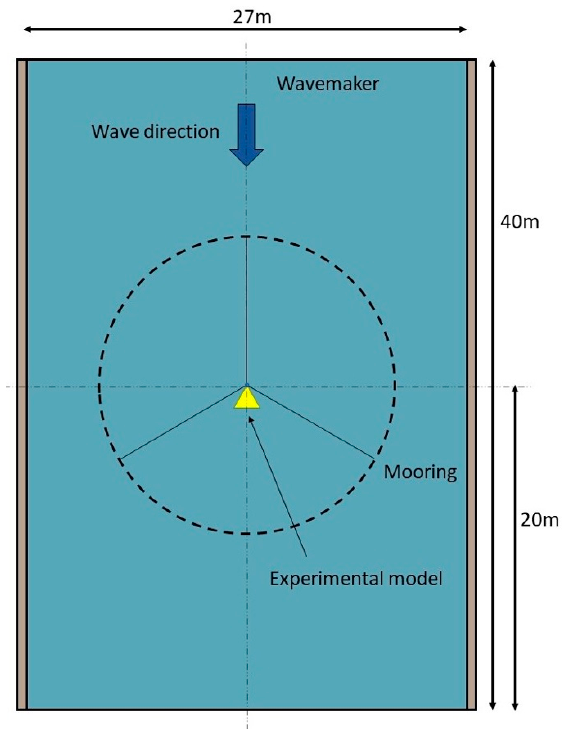
Figure 5. Top view of the wave basin setup.